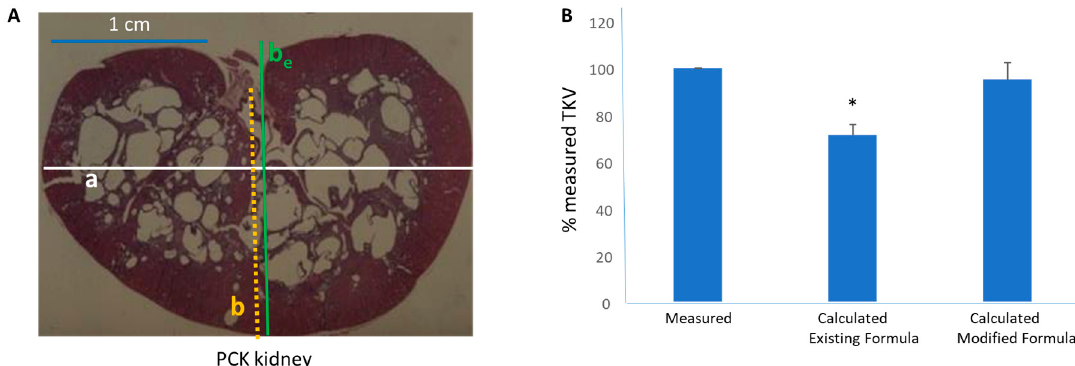
Figure 9. Measured vs. calculated total kidney volume (TKV). ( A ) An H&E-stained coronal renal slice